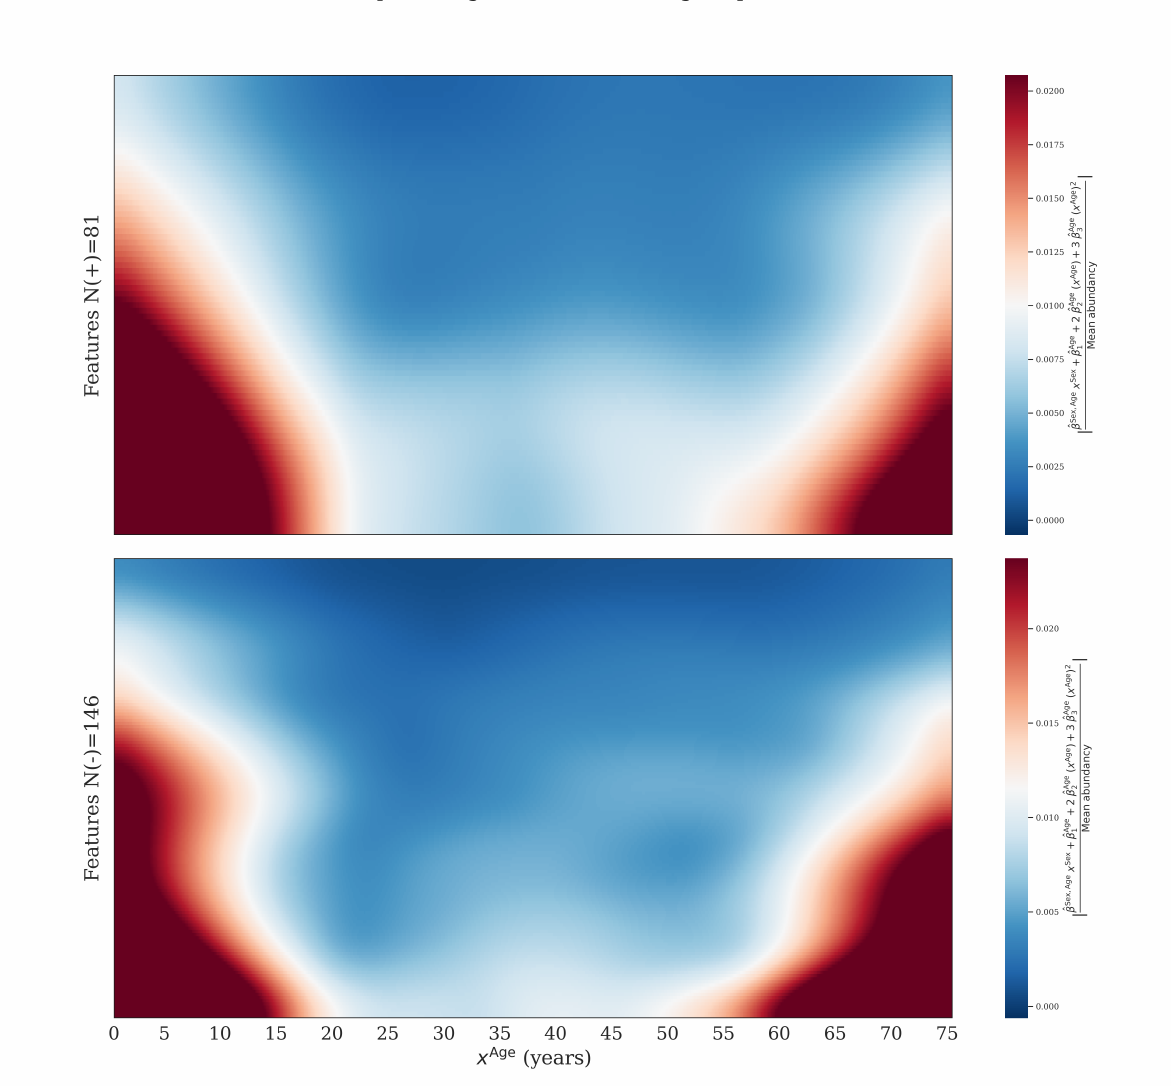
Figure A2. By taking the derivative of the regression model with respect to x Age we obtained the slope at a given age. This figure i < 0.05. Slopes were first divided by the average abundancy to obtain was obtained by plotting these slopes for features where p Age 1 comparable numbers where after the absolute value was taken. Red and orange area’s indicates larger (absolute) values of the slopes. Features were ranked based on there median (absolute) slope, and colors were smoothed. The data was normalized using BC-Metchalizer . We observe that age dependent features have the tendency to increase/decrease in abundancy faster at younger and older ages, implying that a matching reference population for these age groups are more